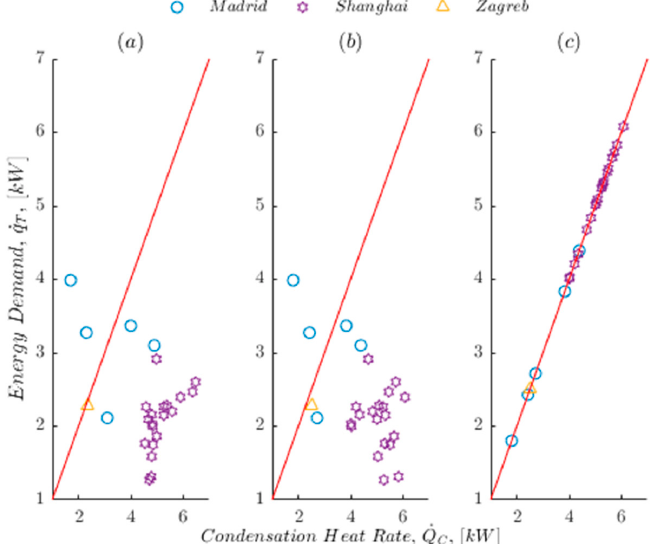
Figure 8. Genetic algorithm overview: ( a ) Experimental results, ( b ) GA-based modelling, ( c ) Optimization implementation.